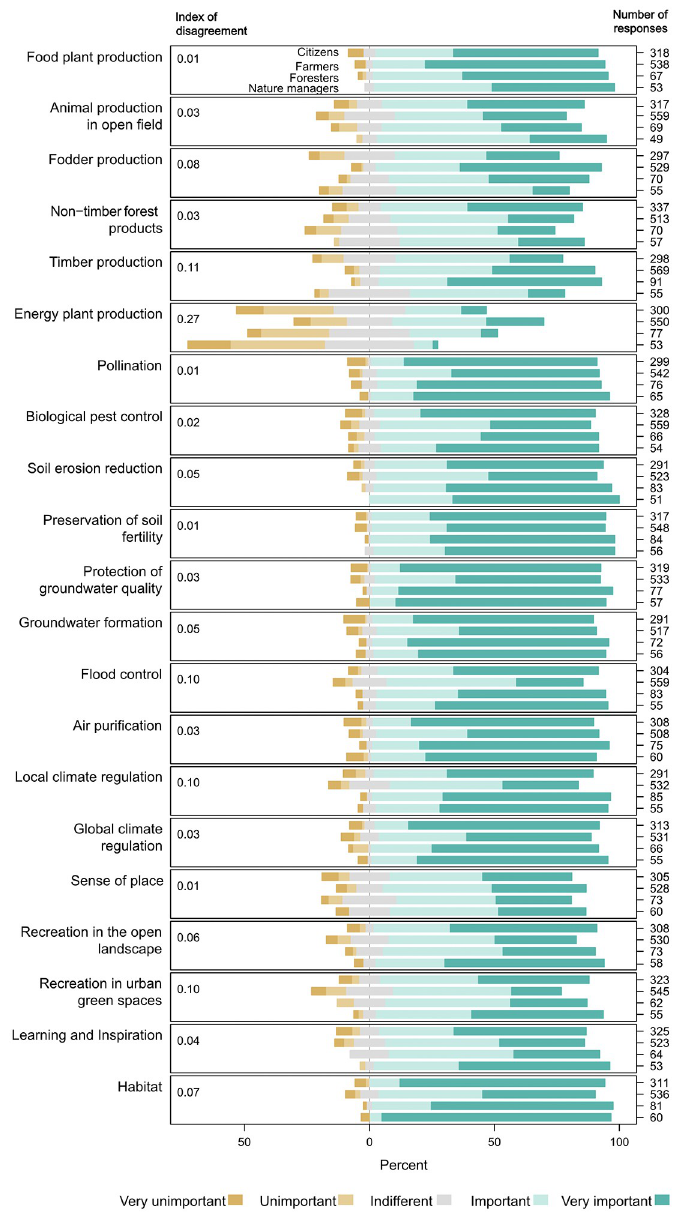
Fig 4. Perceived importance per ecosystem service and societal actor (i.e., citizens, farmers, foresters, and nature managers). The index of disagreement shows differences between societal actors in perceived importance of ecosystem